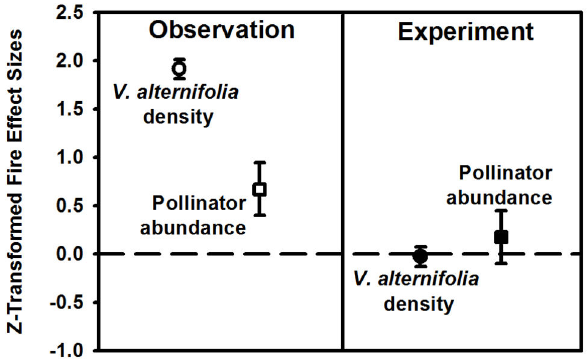
Figure 2. Standardized effects of fire on plant density and pollinator abundance. (Observation) Plant density and